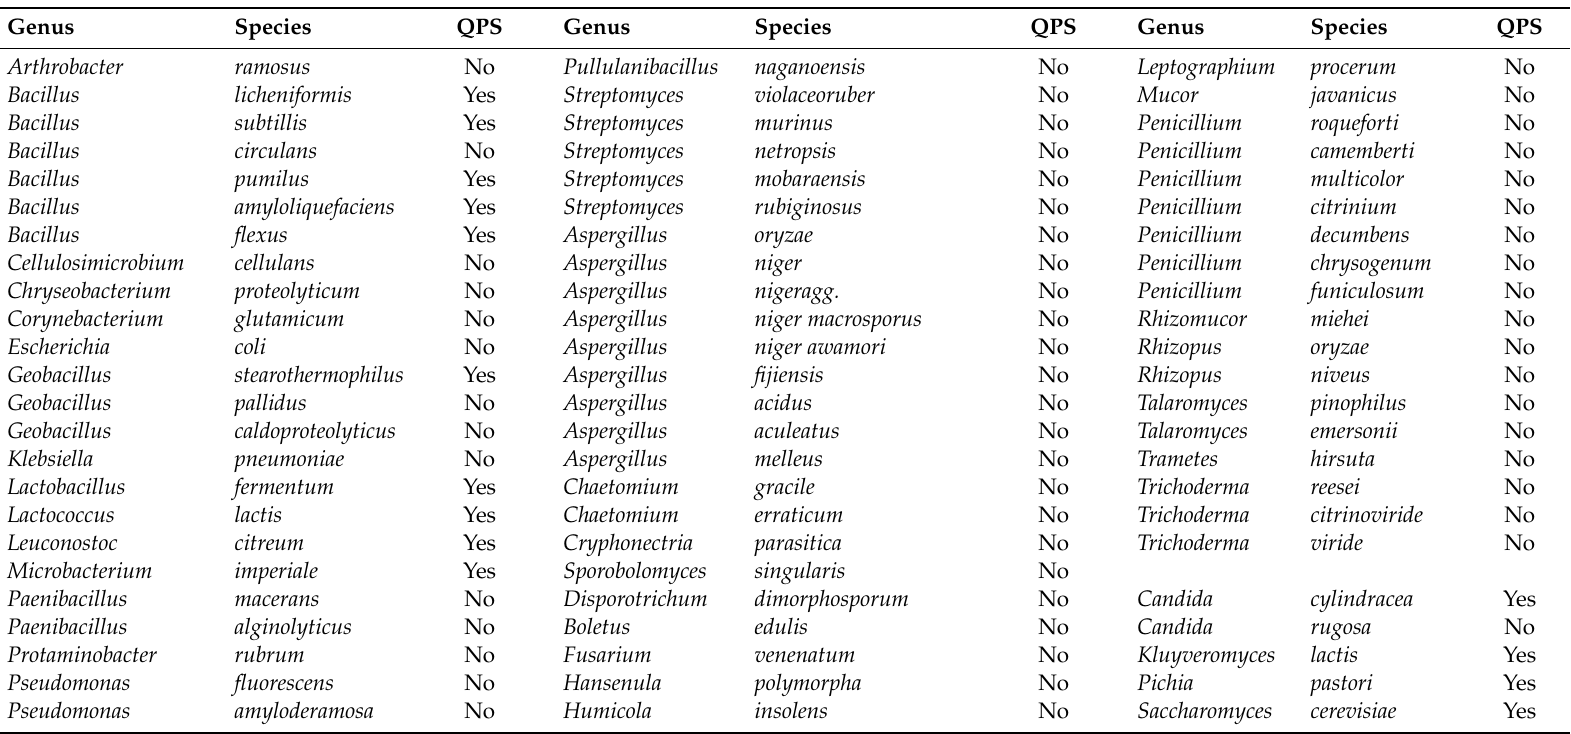
Table 3. Overview of the qualified presumption of safety (QPS) status of the FE-producing micro-organisms (MO) for which a dossier has been submitted to the EFSA for a safety evaluation and subsequent incorporation into the FE community list. The first section contains all bacterial species, the second section contains all filamentous fungal species, and the last section contains the yeast